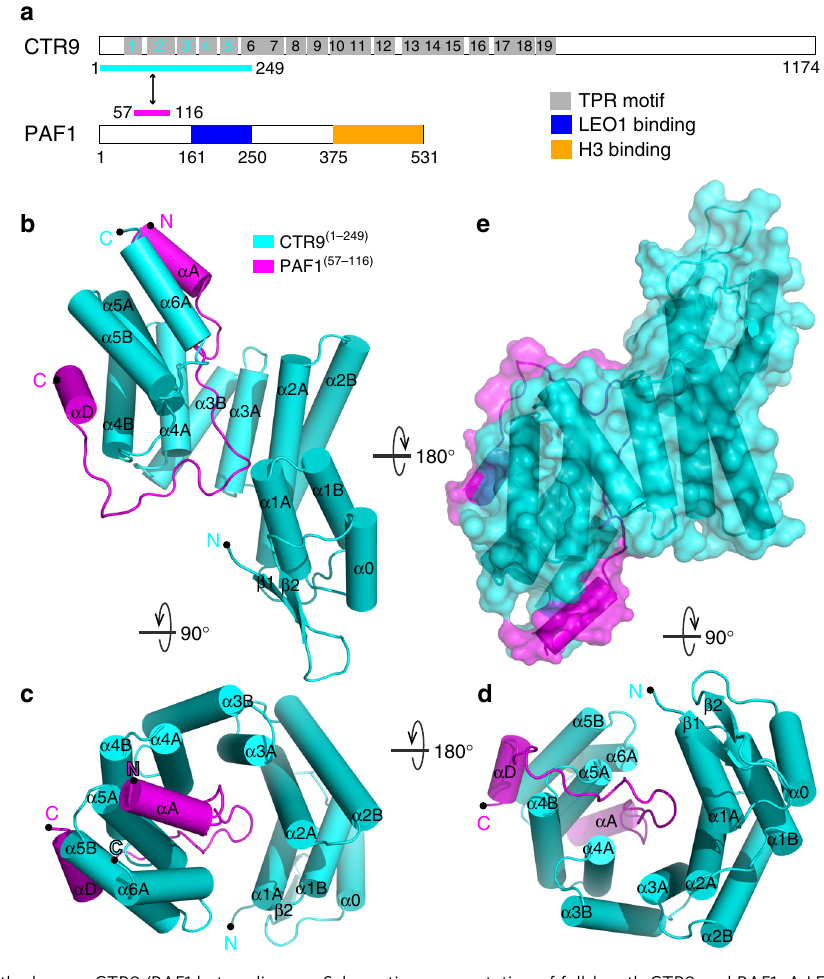
Fig. 1 Crystal structure of the human CTR9/PAF1 heterodimer. a Schematic representation of full-length CTR9 and PAF1. A LEO1-interacting region (blue) and a histone H3-interacting region (orange) are shown in PAF1. The predicted 19 TPR motifs (gray) were de fi ned using TPRpred (https://toolkit. tuebingen.mpg.de/#/tools/tprpred). The protein fragments of the CTR9 (1 – 249) /PAF1 (57 – 116) complex used for structural determination are indicated by a two-way arrow and are colored cyan and magenta, respectively. b Ribbon diagram representation of the CTR9 (1 – 249) (cyan)/PAF1 (57 – 116) (magenta) complex viewed from the side. The N- and C-termini of the two proteins are labeled. Cylinder representation of the CTR9 (1 – 249) /PAF1 (57 – 116) complex structure viewed from the top ( c ) or the bottom ( d ). e Surface representation of the CTR9 (1 – 249) /PAF1 (57 – 116) complex with its orientation corresponding to the other side from that shown in ( b